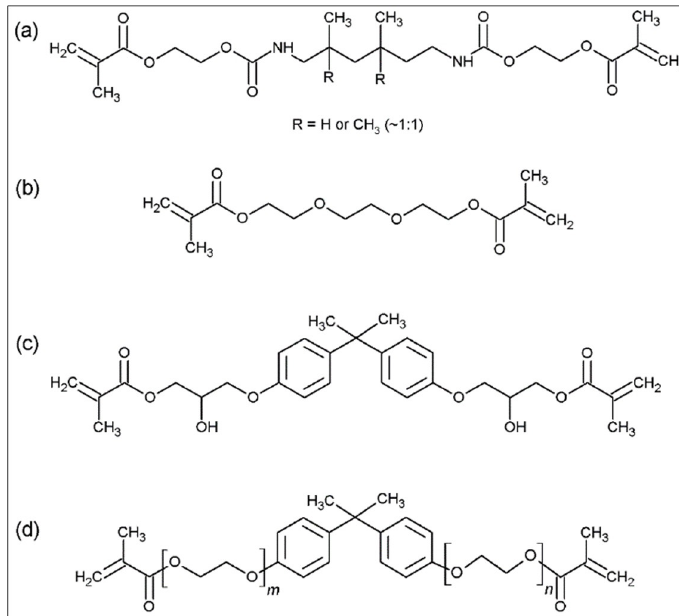
Figure 1. Chemical structure of the monomers used in Filtek Z250 XT: UDMA (a), TEGDMA (b), Bis-GMA (c) and Bis- EMA